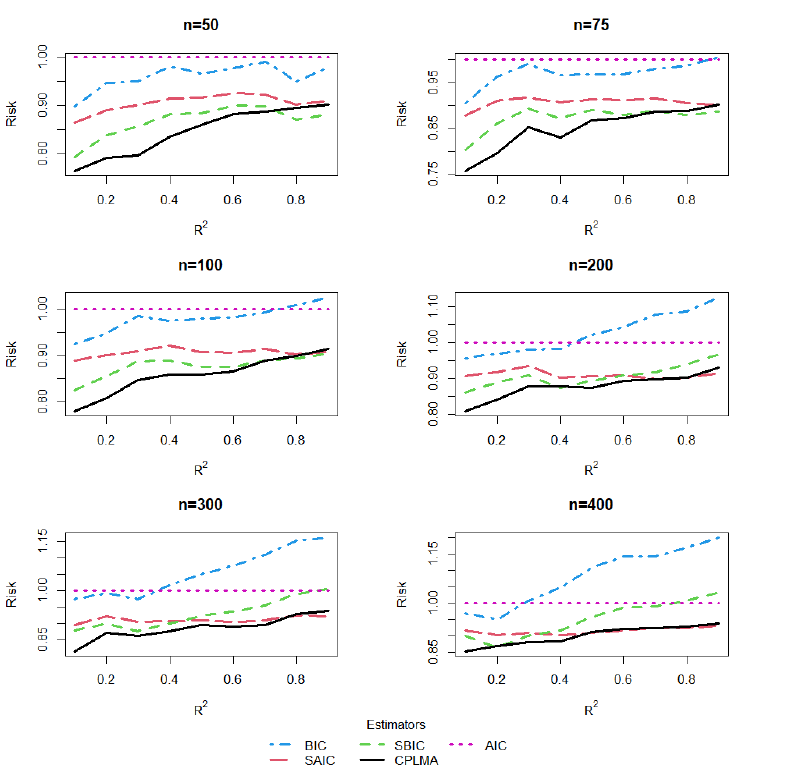
Figure 4. Risk comparisons for Design 1 when α = 2 and the censoring rate is about